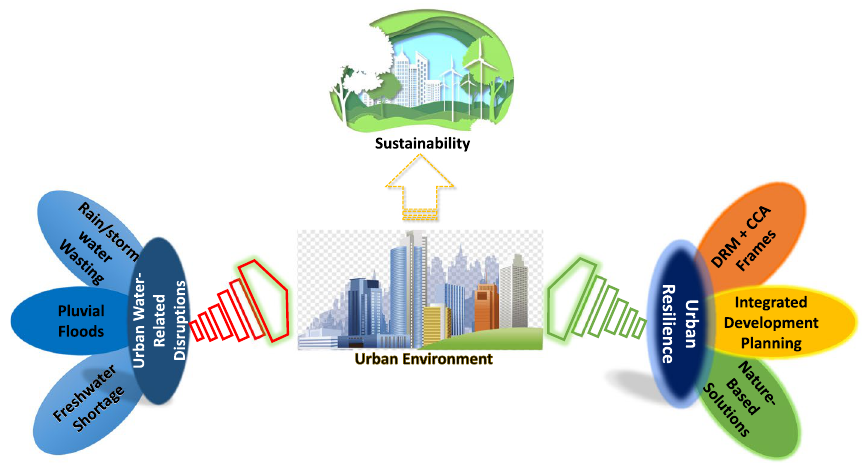
Fig. 3 Research conceptual